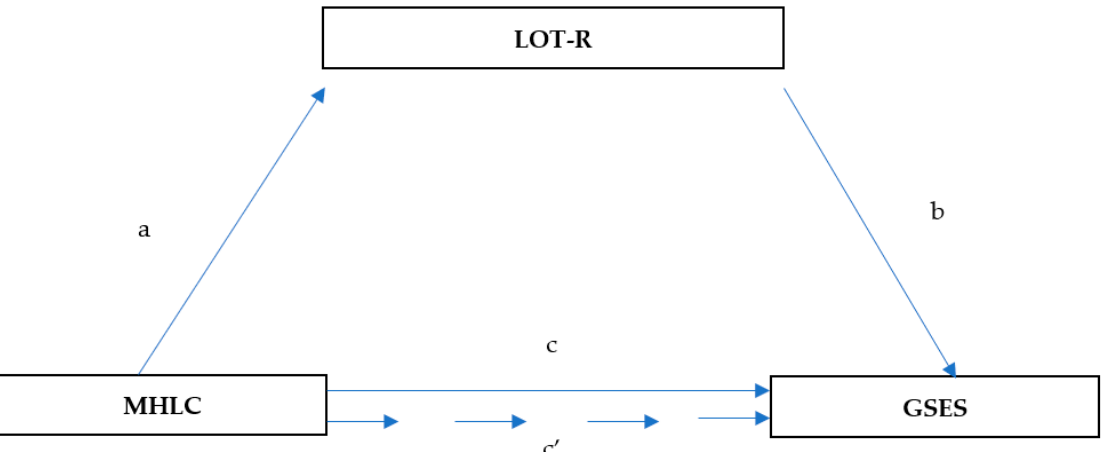
Figure 2. Model of relationships between health locus of control, dispositional optimism, and self- efficacy. (c) The relationship between MHLC and GSES; (a) the relationship between MHLC and LOT-R; (b) the relationship between LOT-R and GSES after controlling for the independent variables; and (c’) the relationship between MHLC and GSES after adding LOT-R as a mediator.